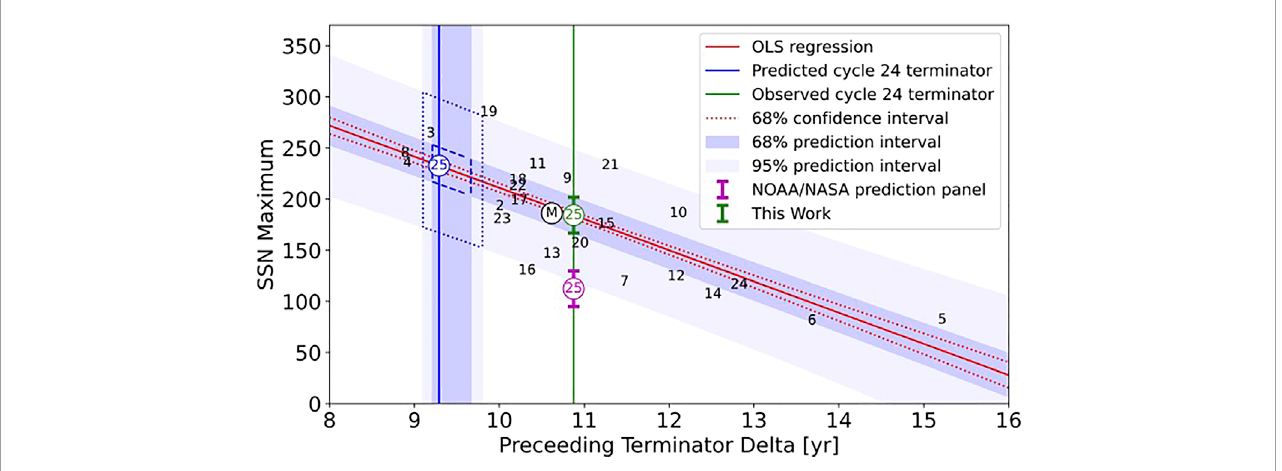
FIGURE 7 Linear regression of the terminator separation vs. upcoming sunspot cycle maximum. The 1 σ (68%) confidence interval, as well as the 2 σ (95%) prediction intervals are shown. The predicted (blue circle and vertical line) and actual (green circle and vertical line) terminator separation for SC24 relative to the consensus prediction of the SC25PP (magenta bar). The dashed and dotted blue lines in are the 68% and 95% prediction interval boundaries for our original SC25 prediction. The black circle indicates the median terminator separation (10.64 years) and median cycle amplitude.